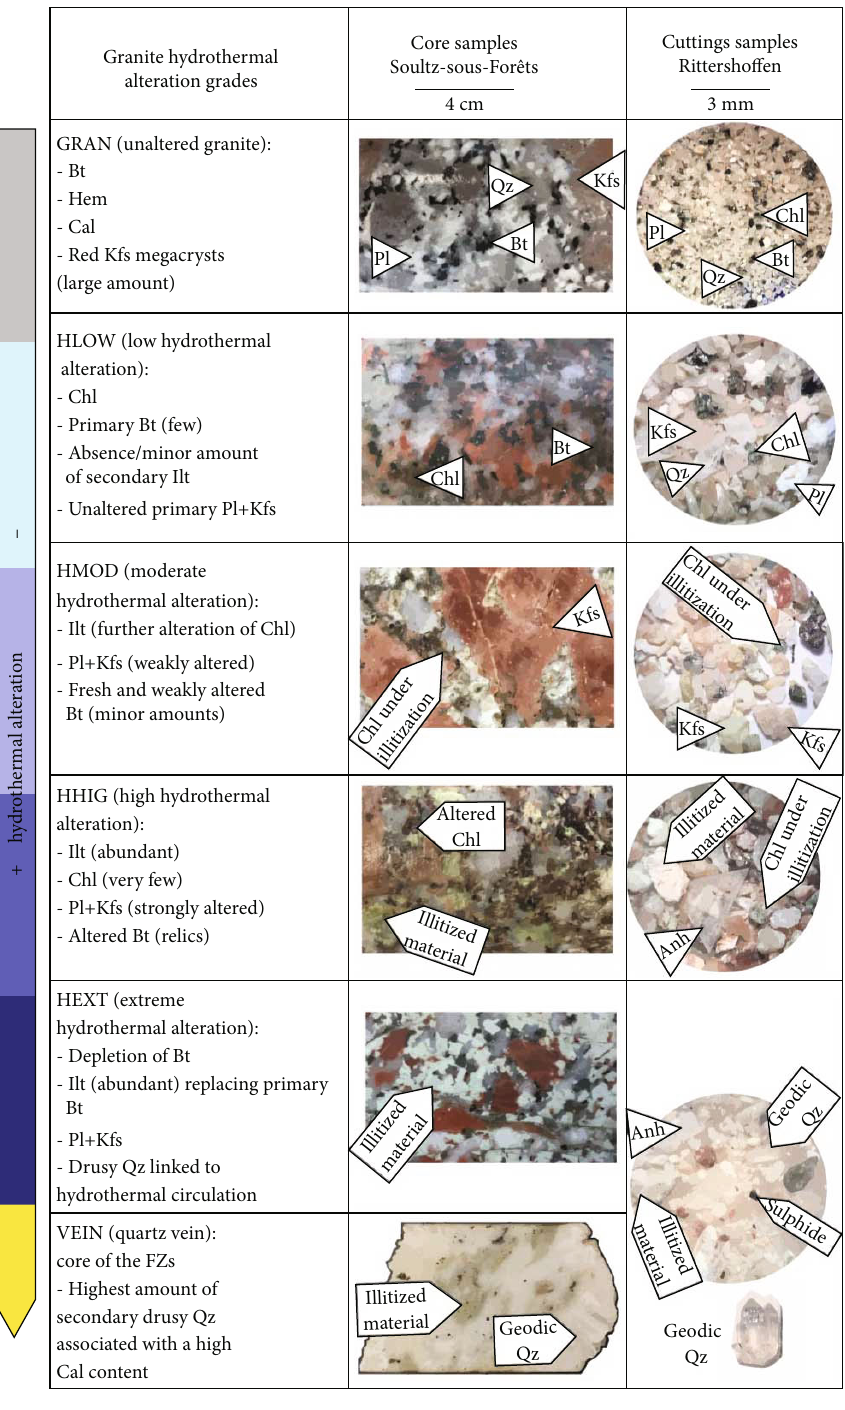
Figure 3: Examples of mineralogical assemblages of the granitic basement observed in cores (middle) and in cuttings (right); these assemblages de fi ne the di ff erent hydrothermal alteration grades (left). GRAN: unaltered granite; HLOW: low hydrothermal alteration; HMOD: moderate hydrothermal alteration; HHIG: high hydrothermal alteration; HEXT: extreme hydrothermal alteration; VEIN: secondary drusy quartz vein; Anh: anhydrite; Bt: biotite; Cal: calcite; Chl: chlorite; Hem: hematite; Ilt: illite; Kfs: potassic feldspars; Pl: plagioclase; Qz: